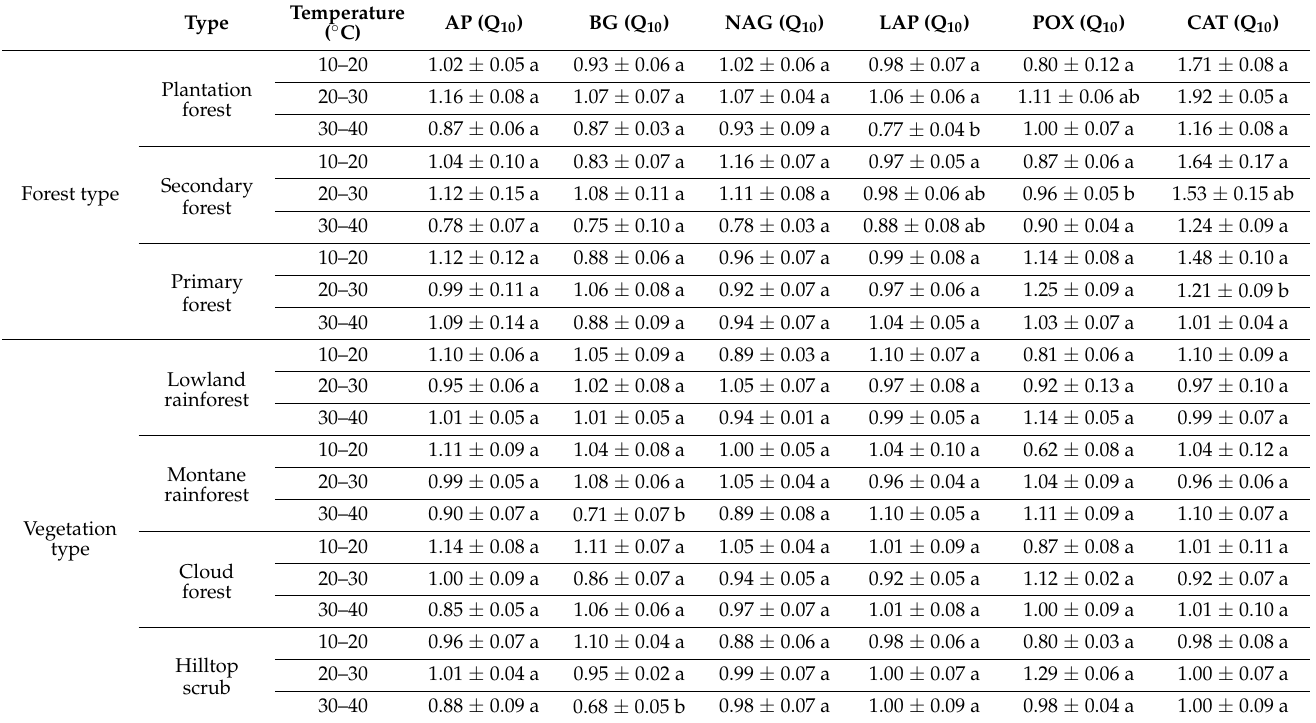
Table 2. The Q 10 value of six enzymes in Wuzhishan National Nature Reserve under three forest types, four slope orientations, and four vegetation types. The numbers are means ± standard error. The letters in lowercase indicate significantly different groups based on Duncan ’ s multiple compar- ison ( p = 0.05).